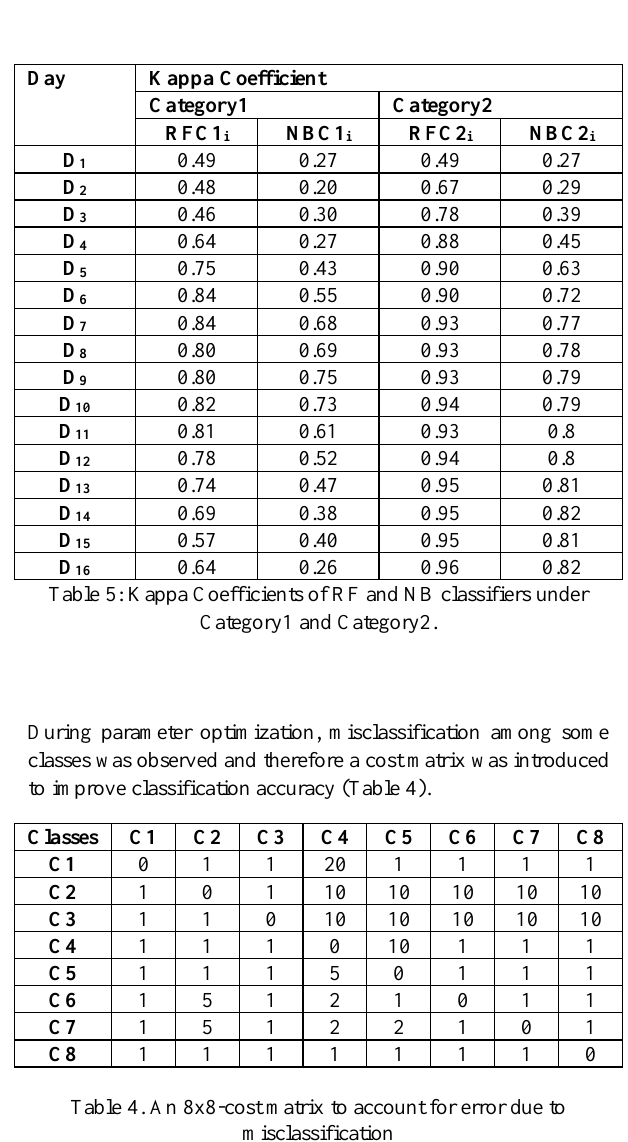
Table 4. An 8x8-cost matrix to account for error due to misclassification